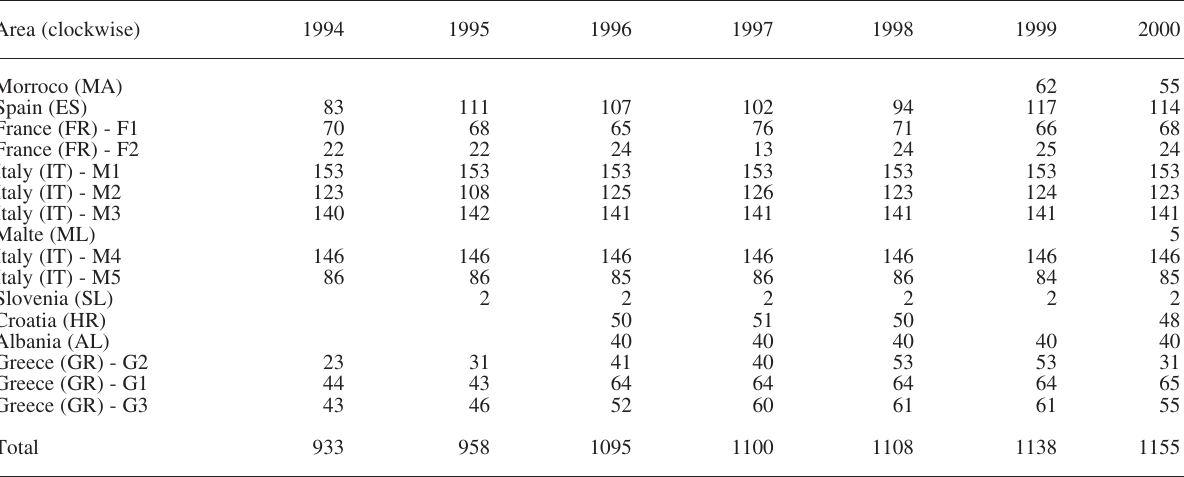
T ABLE 2. – Number of hauls carried out by area during the MEDITS 1994 to 2000